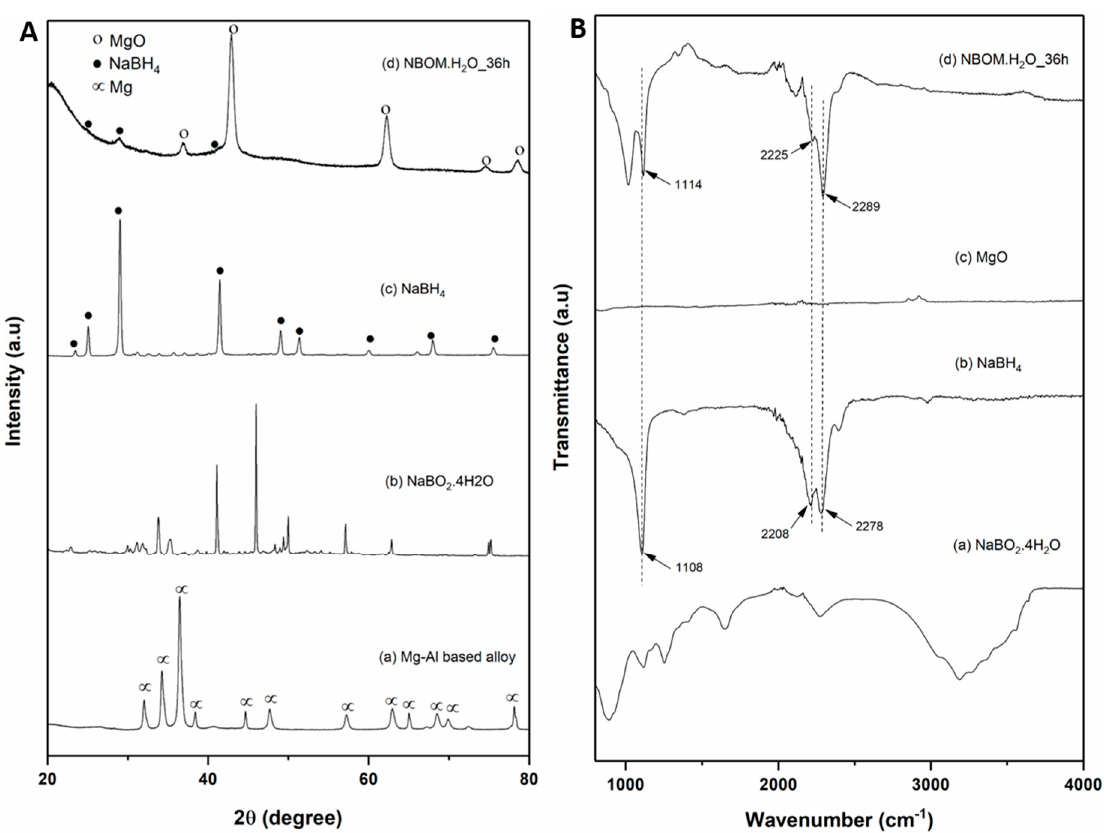
Figure 6. ( A ) XRD di ff ractions of: (a) Mg–Al-based alloy, (b) NaBO 2 · 4H 2 O, (c) NaBH 4 , (d) ball-milled Figure 6. A XRD diffractions of: (a) Mg–Al-based alloy, (b) NaBO 2 ·4H 2 O, (c) NaBH 4 , (d) ball-milled NBOM · H 2 O at 36 h under 1 bar Ar, ( B ) FT-IR spectra of materials: (a) NaBO 2 · 4H 2 O; (b) NaBH 4 ; (c) NBOM·H 2 O at 36 h under 1 bar Ar, B FT-IR spectra of materials: (a) NaBO 2 ·4H 2 O; (b) NaBH 4 ; (c) MgO MgO and ball-milled NBOM · H 2 O at 36 h under 1 bar and ball-milled NBOM·H 2 O at 36 h under 1 bar Ar.